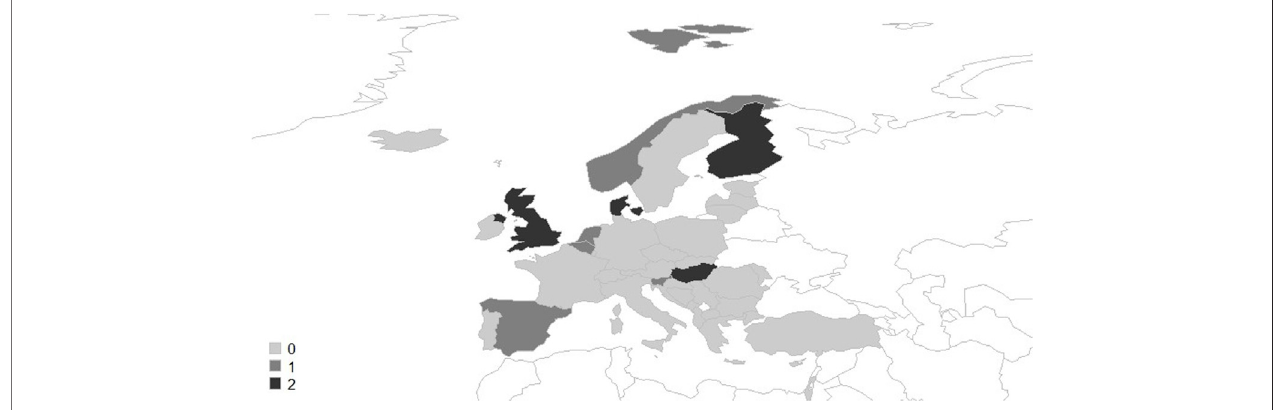
FIGURE 1 | Number of reimbursed medication adherence enhancing interventions across European countries.